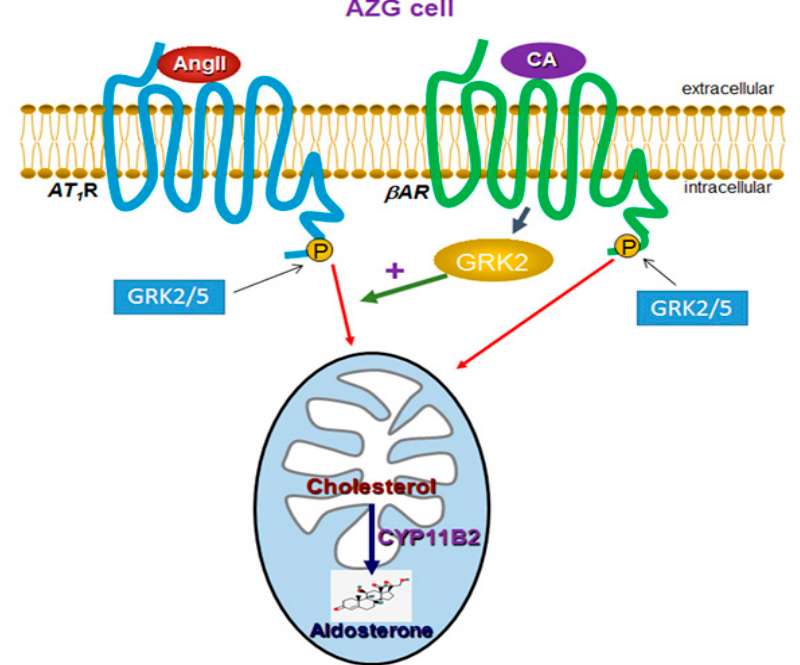
Figure 5. Schematic illustration of the GRK2-dependent signaling crosstalk between β ARs and AT 1 Rs in AZG cells leading to enhanced aldosterone production in vitro and in vivo. Although both GRK2 and -5 can phosphorylate either receptor to induce downstream signaling resulting in aldosterone synthesis in the mitochondria of the AZG cell, β AR-activated GRK2 (but not GRK5) augments the AT 1 R signal to aldosterone induction in AZG cells. CA: Catecholamine. See text for more details and for all other molecular acronym definitions.